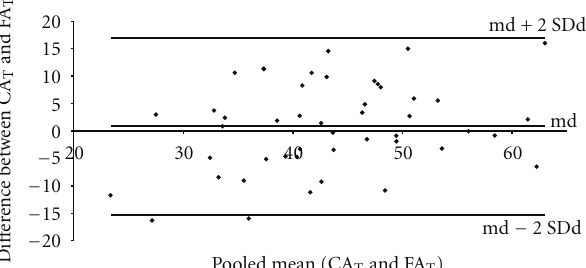
Figure 7: Graphic representation of the degree of agreement in relation to the di ff erence between the CA T and FA T in function of the pooled mean (CA T and FA T ). The thoracic curvature mean of di ff erences (md) = 0.8 ◦ , the Standard Deviation of di ff erence (SDd) = 8.0 ◦ , and the limits of agreement are from − 15.3 to +17.0 ◦ .